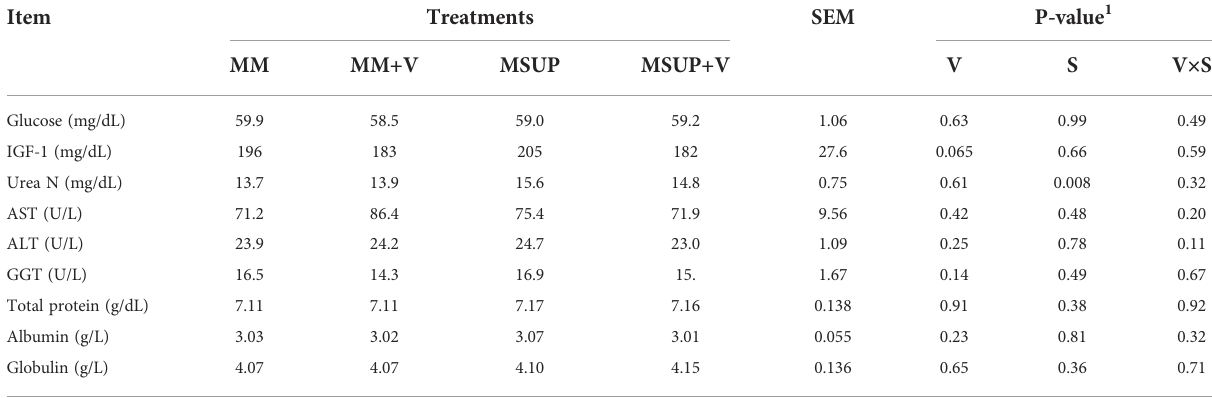
TABLE 7 Effects of feeding multiple supplement and, or virginiamycin on blood characteristics of heifers fed a high-quality tropical forage.